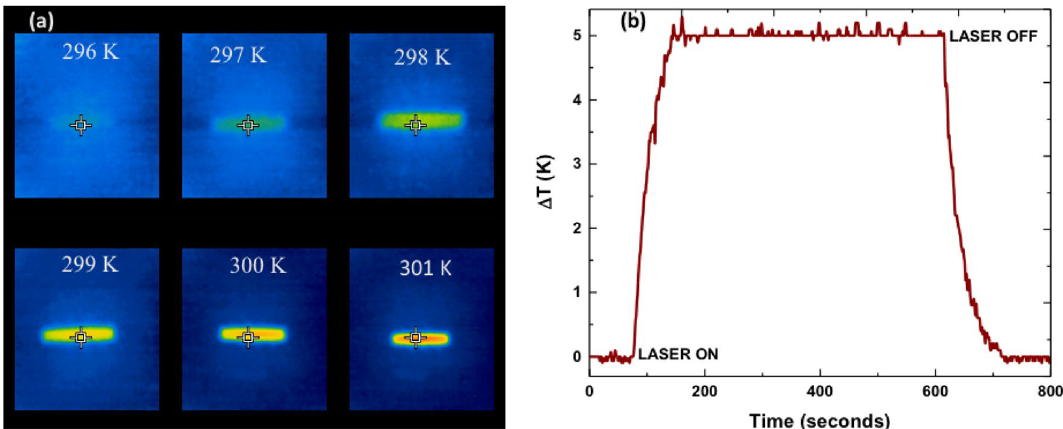
Figure 4. ( a ) The temperature evolution of MCVD SiO 2 glass while it is exposed to 1029 nm 1 W laser obtained through FLIR thermal camera, ( b ) (cid:31) T vs. time curve of MCVD SiO 2 glass while pumping with 1 W at 1029 nm measured using FBG direct contact